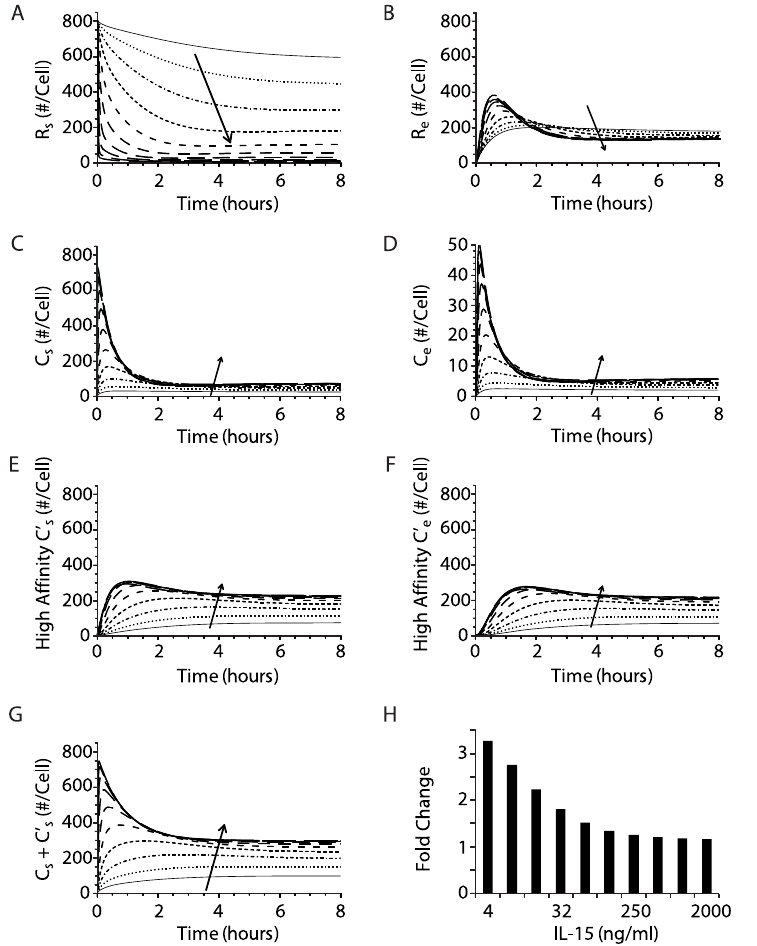
Figure 6. The upregulation of IL-15R a amplifies IL-15R signaling and modulates the steady state numbers of receptors, complexes, and ligands on the cell surface and in endosomes of dividing NK cells. Numerical solutions of the computational model are depicted in two columns, showing receptor, intermediate affinity complex, and high affinity complex at the cell surface ( A , C , E ) and in endosomes ( B , D , F ). Model solutions were obtained from simulations where IL-15 concentration serially doubled from 3.9 ng/ml to 2000 ng/ml, represented by different lines with the arrow denoting increasing IL-15 concentration. G . The total number of signaling complexes at the cell surface is shown as the sum of intermediate and high affinity complexes. H . Fold change in total steady state cell surface IL-15/IL-15R complex numbers on dividing cells (with upregulation IL-15R a ) compared with quiescent NK cells (which express no appreciable IL-15R a ). The fold changes in this ratio at different IL-15 concentrations (serially doubled from 3.9 to 2000 ng/ml) are depicted by solid bars.